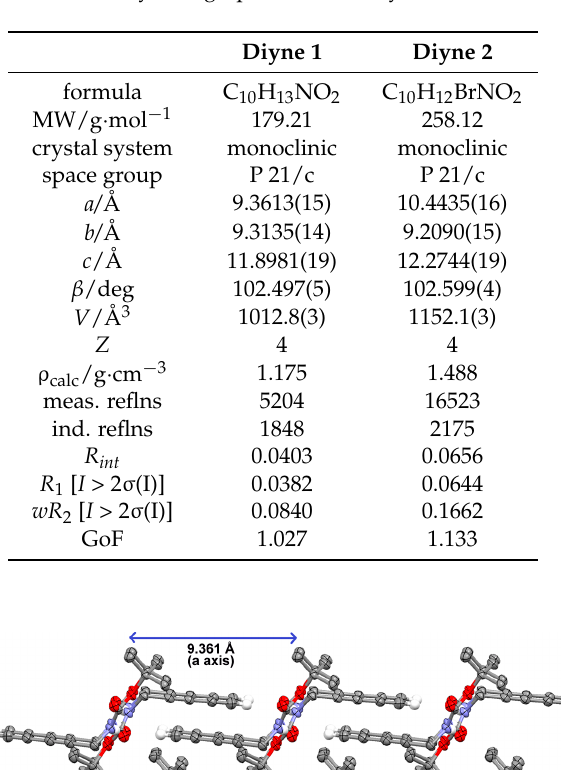
Table 1. Crystallographic data for diynes 1 and 2 .